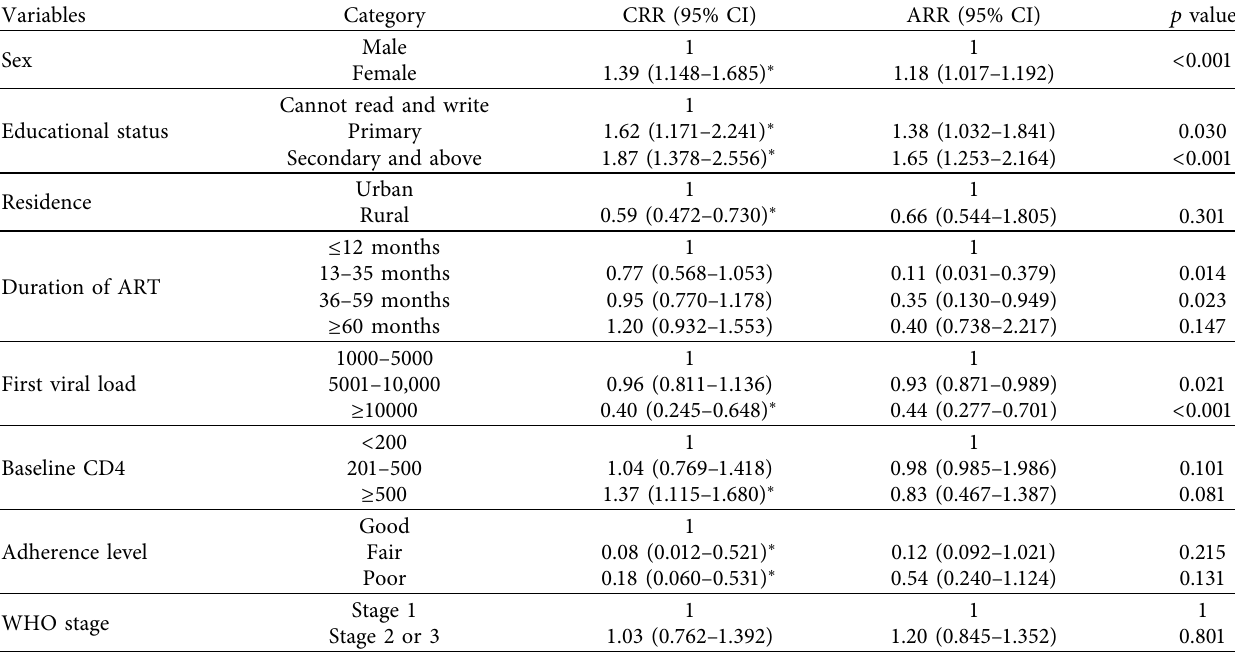
Table 3: Baseline demographic and clinical characteristics associated with viral load suppression among high viral load HIV infected people after enhanced adherence counselling (EAC) session between June 2016 and January 2019, Ethiopia.